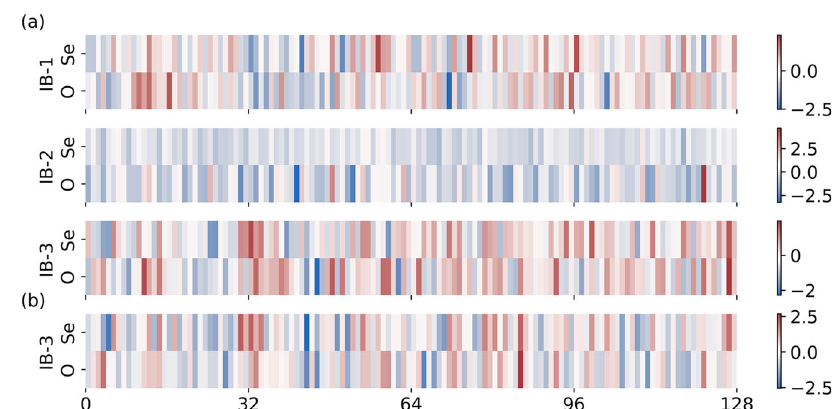
Fig. 2 Element-wise feature vectors. a Outputs from three successive interaction blocks for SeO 2 (Tetragonal P 4 2 / mbc space group). b Outputs from the third interaction block for SeO 2 (Orthorhombic Pmc 2 1 space group). The materials ID from the Materials Project for materials in ( a ) and ( b ) are mp-726 and mp-559545, respectively.